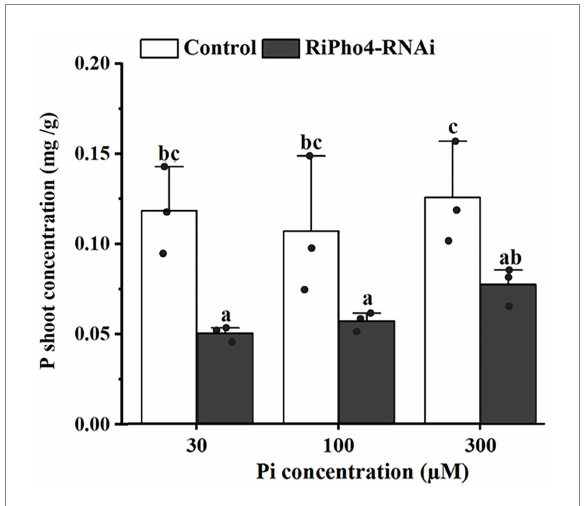
FIGURE 7 Phosphate concentrations in the tobacco ( N. benthamiana ) shoots of the control and VIGS of RiPho4 treatments under different Pi conditions. The data represented the means with SE. Different letters indicated the significant differences which statistically analyzed by Duncan’s multiple range test at the alpha = 0.05